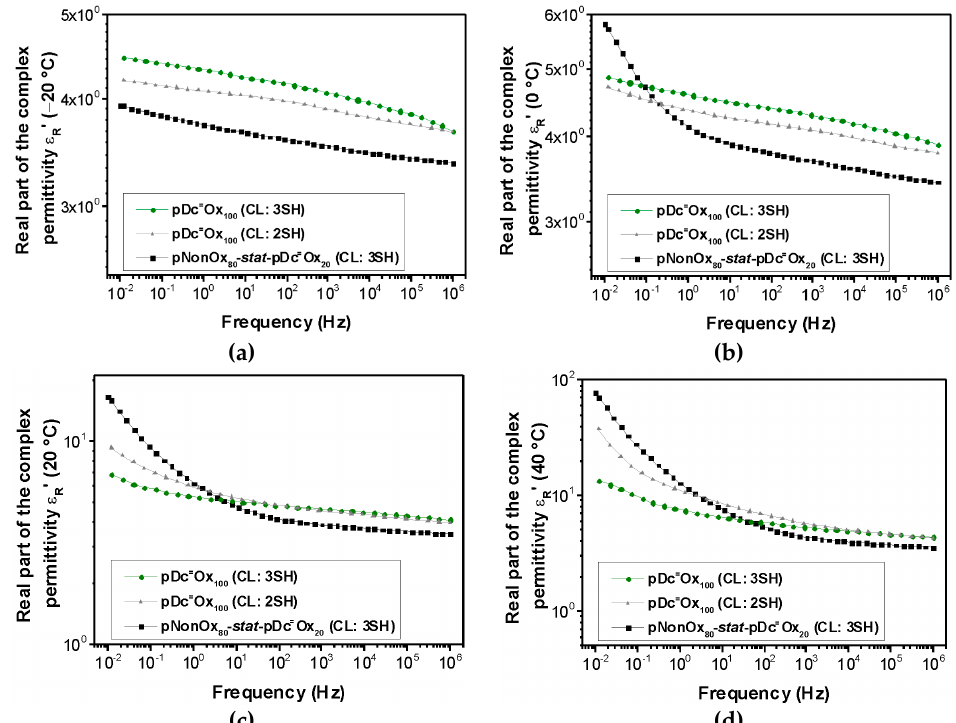
Figure 1. Frequency-dependent real part of the complex permittivity of pNonOx 80 - stat -pDc = Ox 20